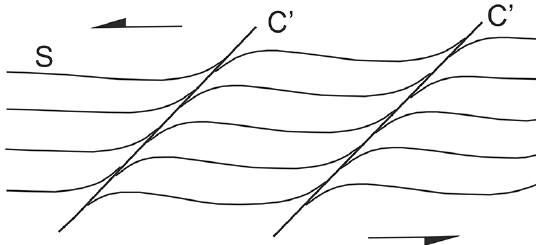
Figure 10. Schematic illustration of S–C (cid:48) fabric. A set of exten- sional shear bands C (cid:48) forms oblique to the shear zone boundaries, dipping towards the shear direction in synthetic orientation. See also Fig. 16.22 in Fossen